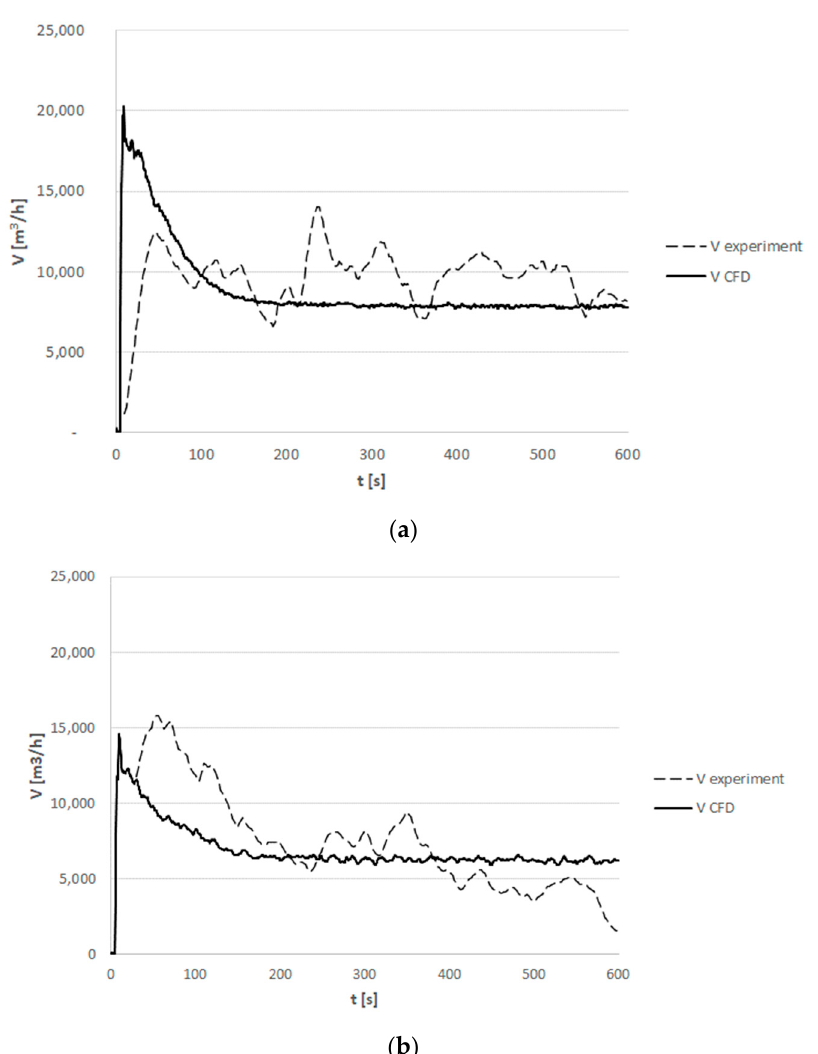
Figure 11. The experimental data made use of moving averages (step 10 for Tout = − 2.0 ◦ C and step 30 for Tout = 35.4 ◦ C).